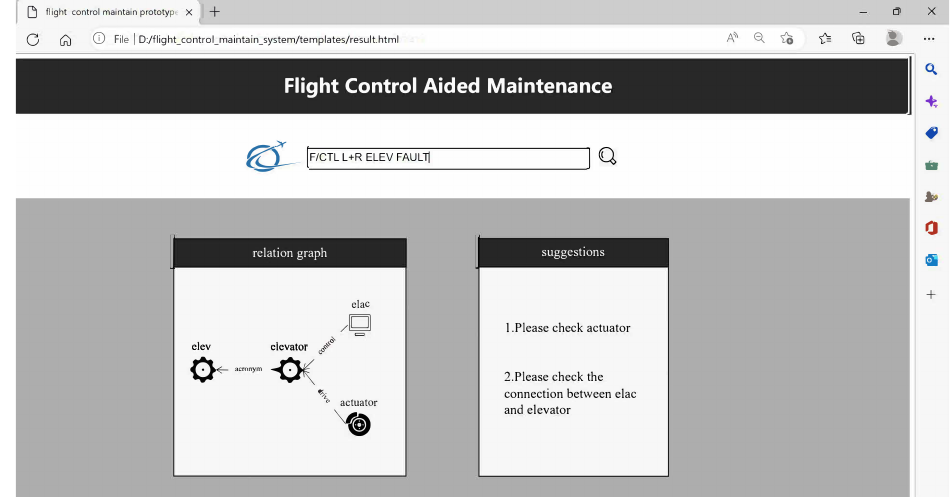
Figure 10. Example of querying “F/CTL L + R ELEV FAULT”.